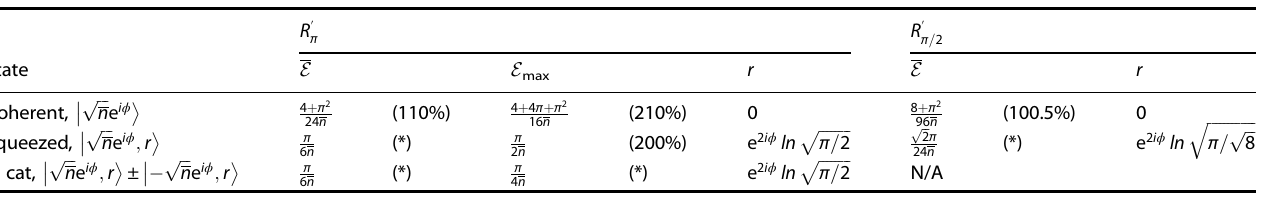
Table 1. Analytical expressions for gate errors using different drive states R ′ π R ′ π =